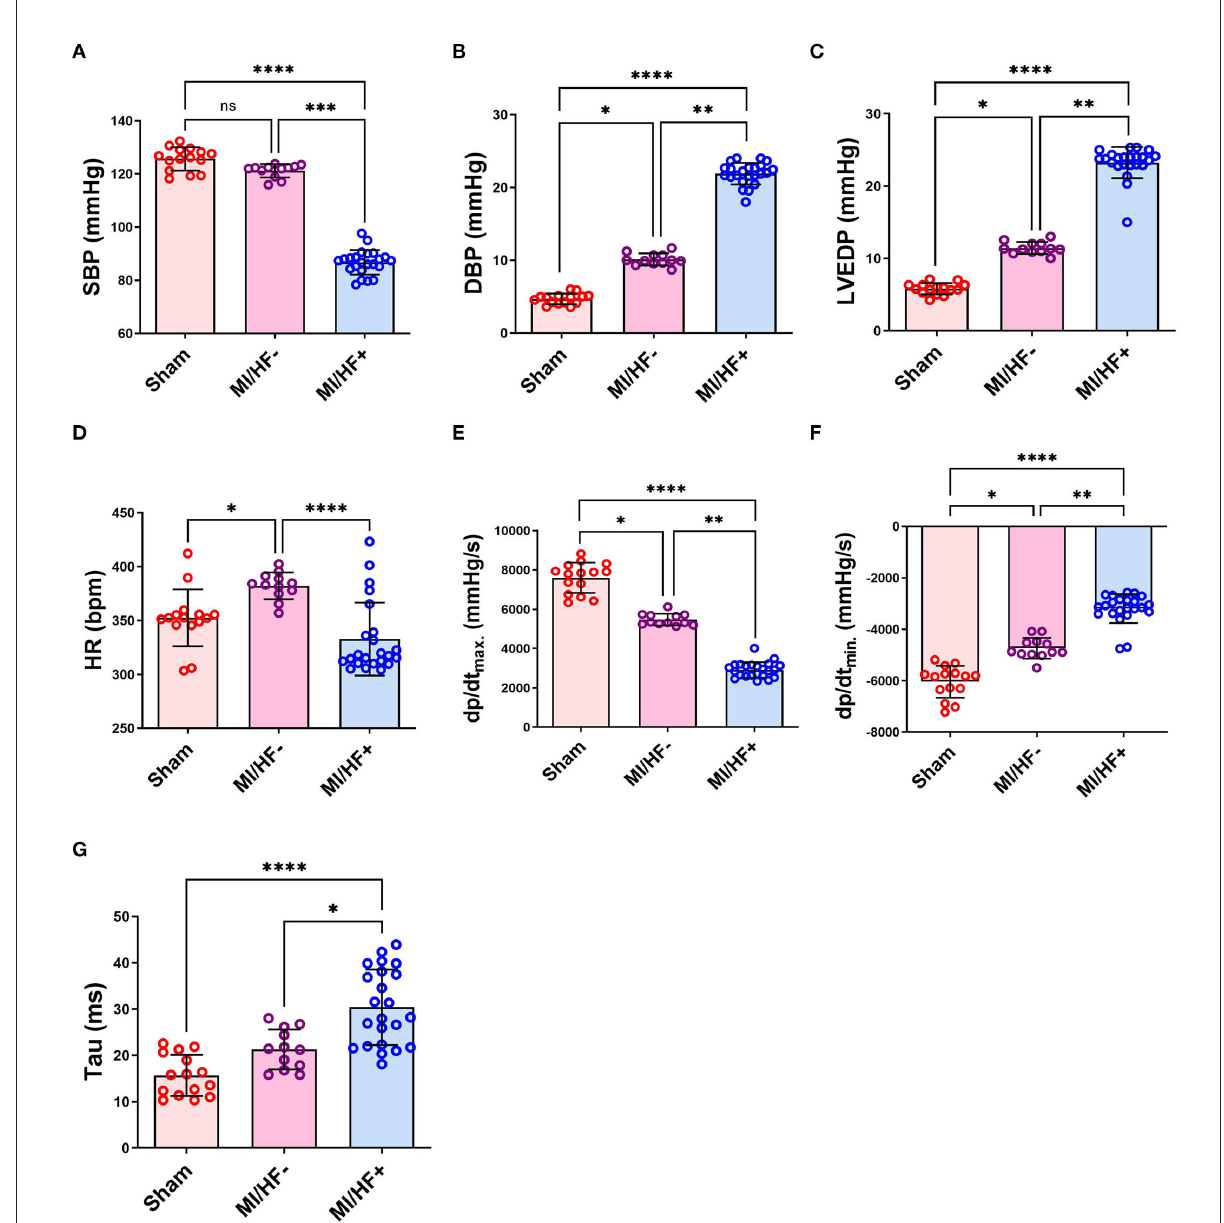
FIGURE4 Scatter plots with bars presenting a quantitative comparison of various hemodynamic parameters in different groups including systolic blood pressure (SBP) (A) , diastolic blood pressure (DBP) (B) , left ventricular end-diastolic pressure (LVEDP) (C) , heart rate (HR) (D) , positive left ventricular pressure derivative (dP/dt max. ) (E) , negative left ventricular pressure derivative (dP/dt min. ) (F) , and time constant of isovolumic relaxation (Tau) (G) . Data presented as mean ± SD. * p < 0.05, ** p < 0.01, *** p < 0.001, and **** p < 0.0001.